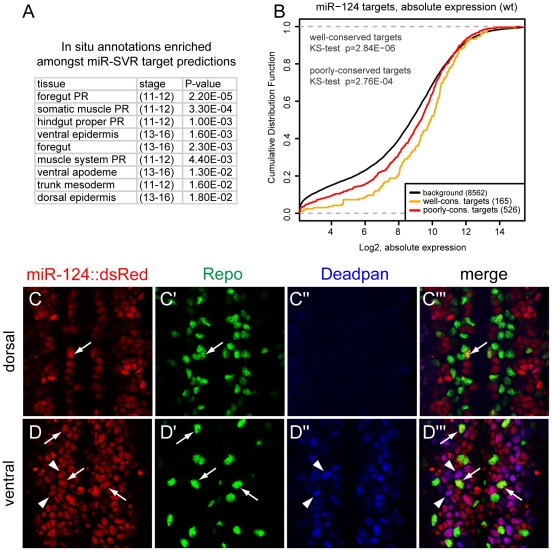
Lack of evidence for mutual exclusion amongst the functional miR-124 target network.(A) Consistent with earlier reports [15], transcripts bearing miR-124 target sites predicted by mirSVR are enriched for genes annotated with non-neural expression. The top enriched tissue annotations are shown in rank order. (B) The absolute levels of transcripts bearing miR-124 target sites in miR-124:DsRed+ cells are well above average gene expression. Moreover, transcripts bearing well-conserved sites are overall more highly expressed than those with poorly-conserved sites. (C, D) Triple label of stage 14 embryos for miR-124:DsRed, Repo (a glial marker) and Deadpan (a neuroblast marker). (C) In more dorsal planes lacking neuroblasts, miR-124:DsRed is excluded from most Repo+ cells, although rare cells show colocalization (arrow). (D) In more ventral planes containing NBs, miR-124:DsRed colocalizes with Deadpan+ cells (arrowheads) as well as Repo+ (arrows) cells inferred to be glioblasts.